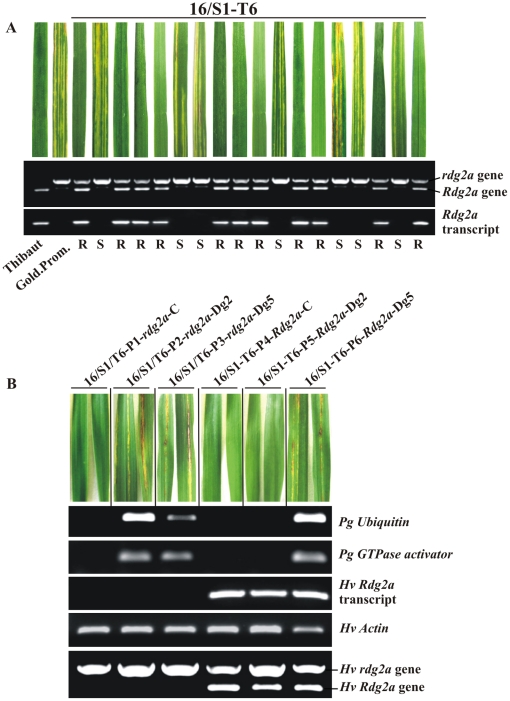
Analysis of T1 family 16/S1-T6 segregating for the Nbs1-Rdg2a transgene.(A) T1 seeds were inoculated with P. graminea isolate Dg2 and plants analyzed for disease symptoms in leaves (upper panel), an STS marker for Rdg2a (middle panel; upper band represents the rdg2a susceptibility allele from cv. Golden Promise while the lower band represents the Rdg2a transgene or endogenous gene), and Rdg2a transgene or endogenous gene expression by RT-PCR (lower panel). Resistance (R) or susceptibility (S) status of the plants is indicated underneath. The resistant cv. Thibaut and the susceptible cv. Golden Promise provide controls. (B) Leaves of six 16/S1-T6 T1 plants were analysed for expression of the fungal (Pg) Ubiquitin and GTPase activator genes and the barley (Hv) Rdg2a gene by RT-PCR. Seeds had been inoculated with Dg2 or Dg5 leaf stripe isolates or were non-inoculated (C). The barley β-actin gene was used as an internal control. Plant DNA was also tested for the presence of the transgene using the Rdg2a STS marker described in (A).